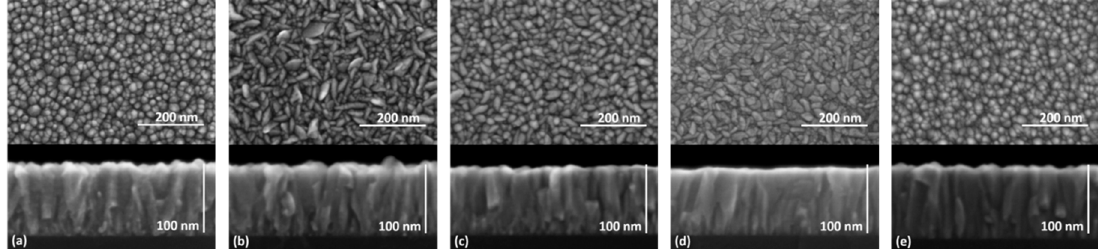
Figure 3. SEM images of analyzed ZnO water-based samples: top-view ( top panel ) and cross section ( bottom panel ). The results for samples grown at 50 °C ( a ), 100 °C ( b ), 150 °C ( c ), 200 °C ( d ), and 250 °C ( e ) are shown.